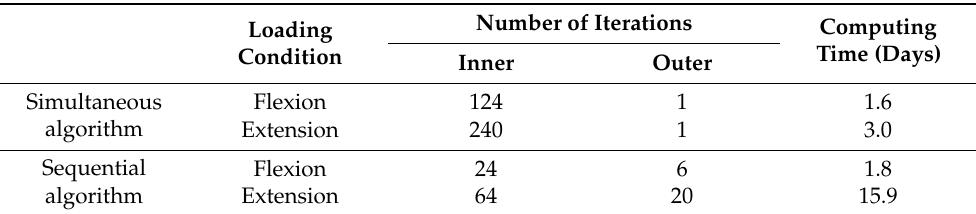
Table 1. Computing time for simulating bone formation after ACDF using the simultaneous and sequential